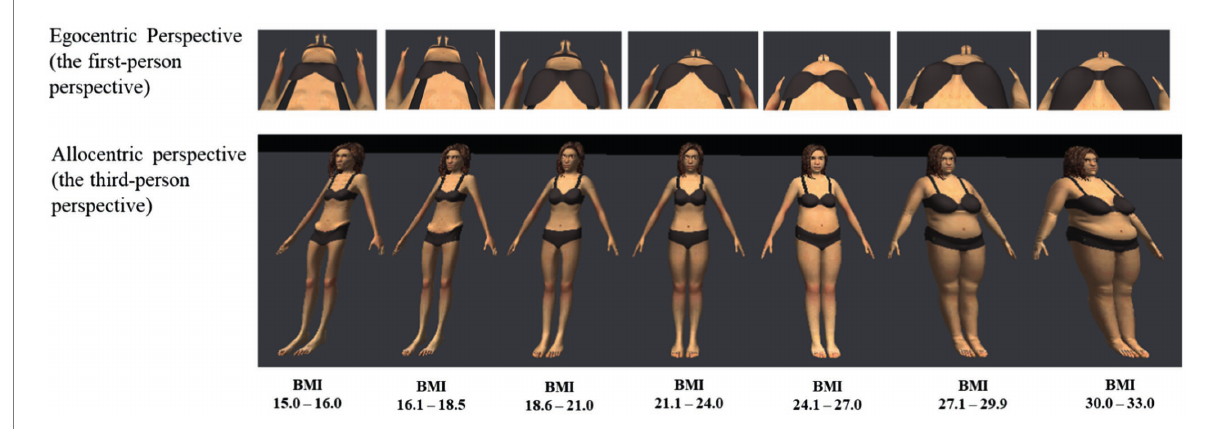
FIGURE 1 Egocentric and allocentric perspectives of eLoriCorps Immersive Body Rating Scale used with females participants. The screenshots are not perfect replicas of images displayed in VR because of variations in viewpoints in the egocentric illustration and a fisheye distortion in the allocentric illustration. Illustration reproduced from Monthuy-Blanc et al. (2022) with the permission of the authors under the Creative Commons Attribution